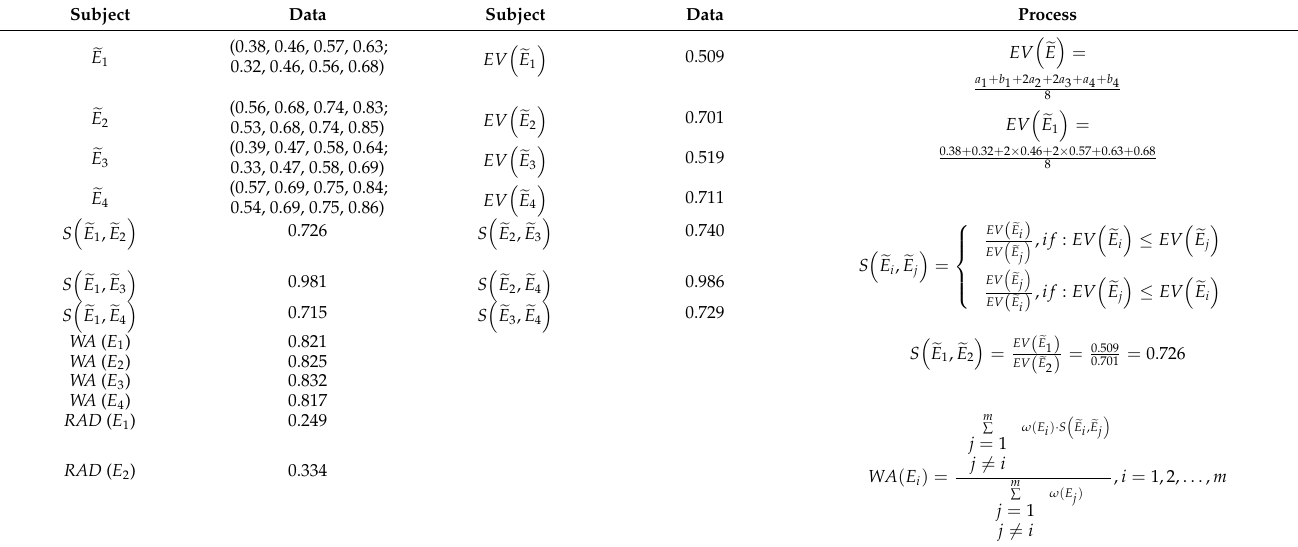
Table 14. Detailed aggregation and FP calculation process of the node X 18